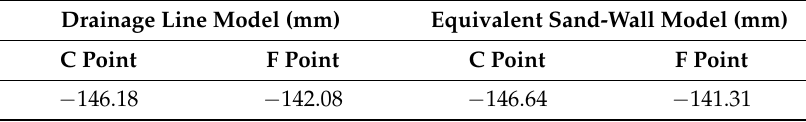
Figure 16. Displacement diagram of the vertical increment according to the model of the equivalent sand-wall in the first year of operation. Table 8. The creep settlement according to the numerical calculation.